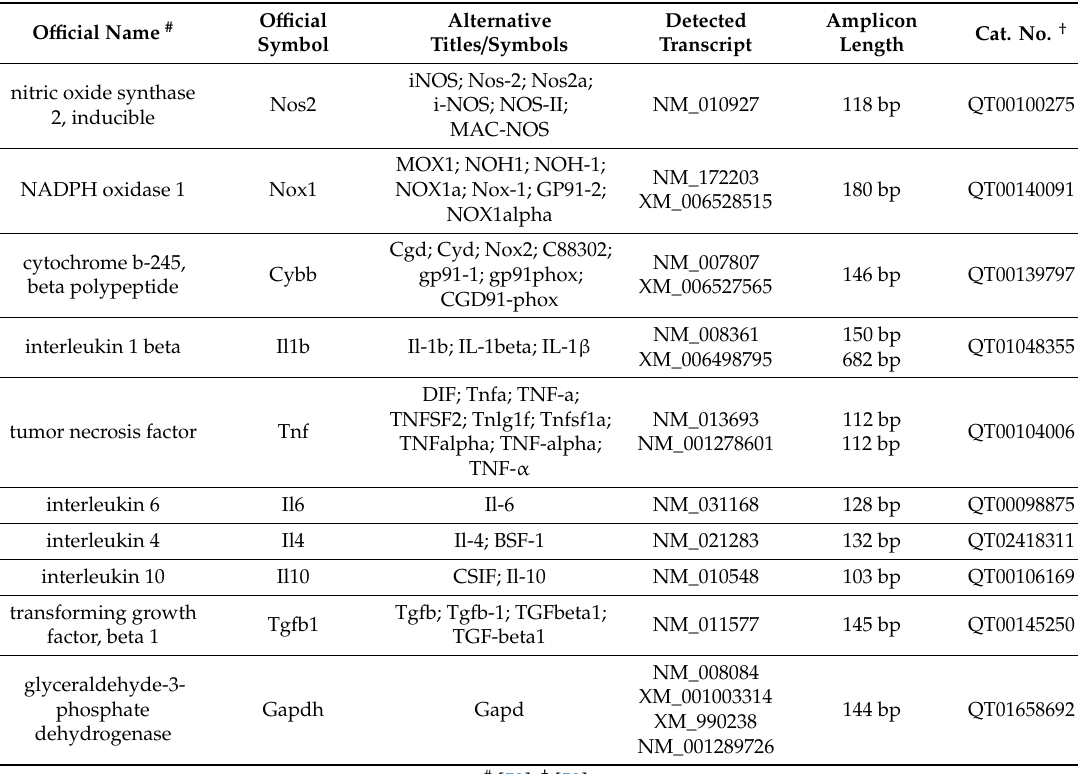
Table 1. The list of primers used for quantitative real-time PCR